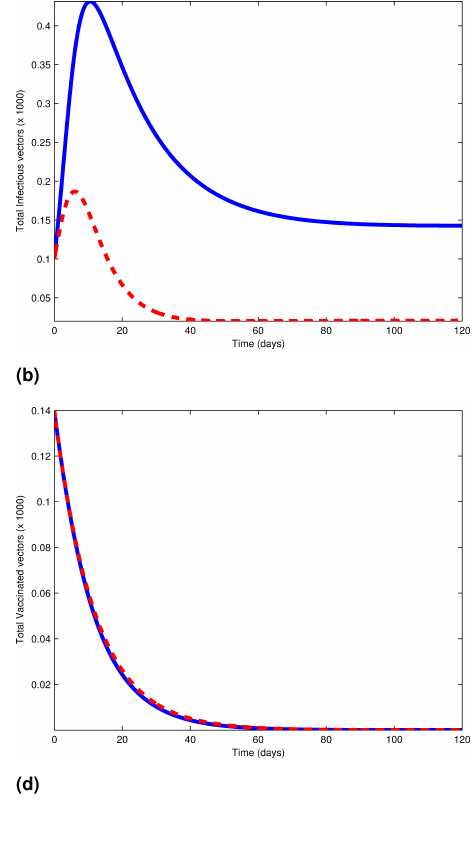
Fig. 4. Simulations of the leptospirosis model showing the effect of the optimal strategies: Vaccination and treatment of infectives vectors. The blue lines represent the cases without control, while the red lines indicate the cases with optimal